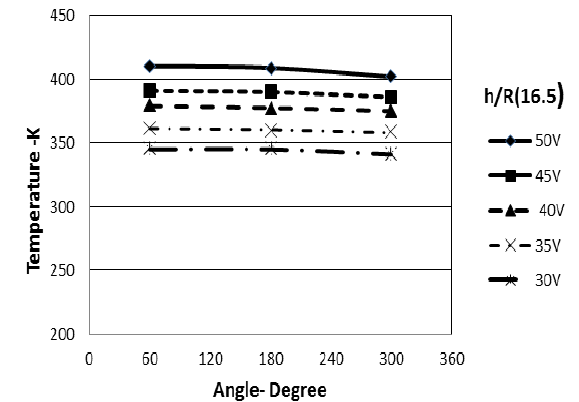
Figure 4. Comparison between the experimental and the estimated mean Nusselt number [5]